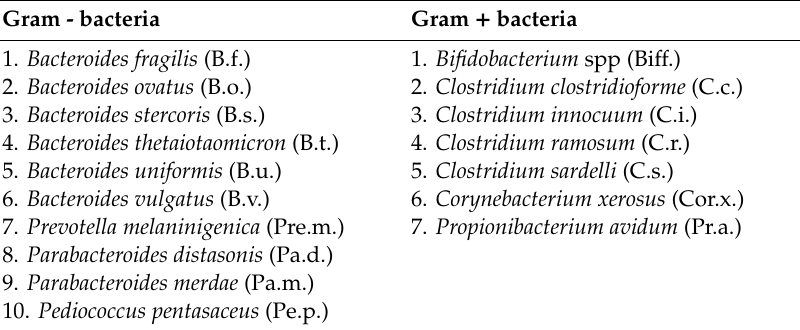
Table 2. The main bacterial species from fecal samples in the study